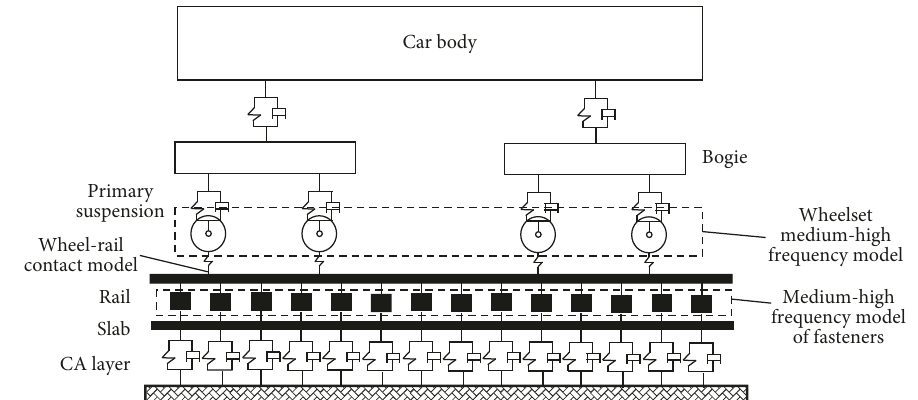
Figure 4: Dynamic model of the vehicle-track coupling system.